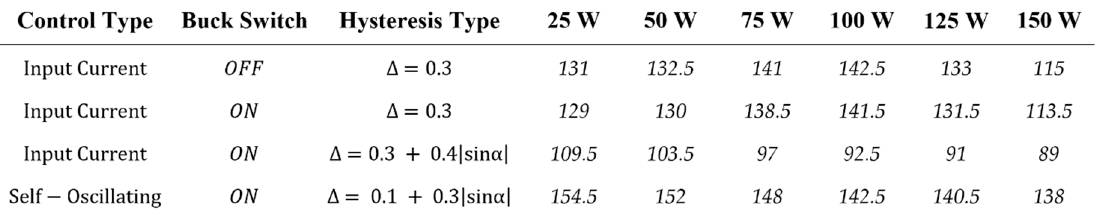
Figure 30. Microinverter maximum and minimum switching frequency in kHz.